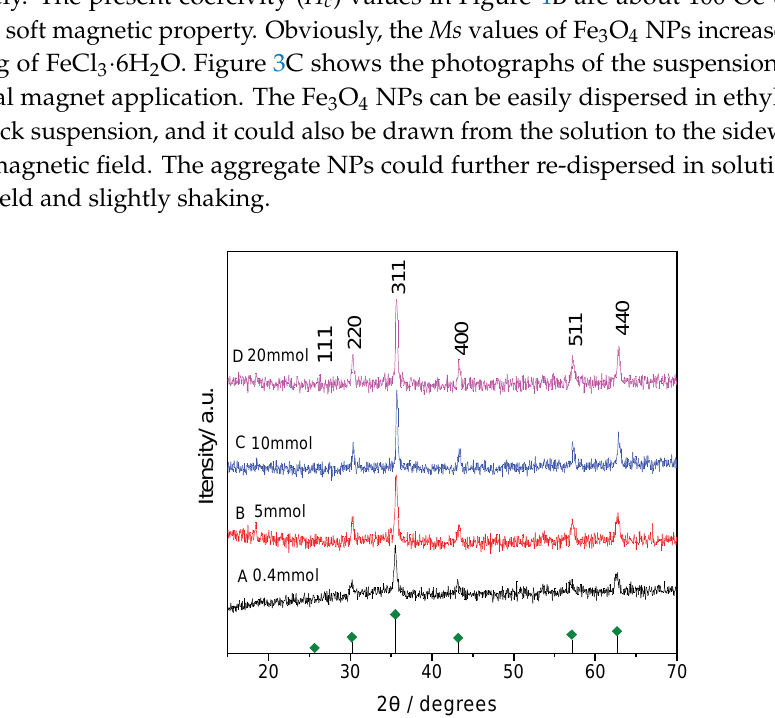
Figure 2. TEM images and size distribution patterns of Fe 3 O 4 with different molar ratio of FeCl 3 ·6H 2 O, ( A ) 0.4 mmol; ( B ) 5 mmol; ( C ) 10 mmol; ( D ) 20 mmol, the insets are the corresponding size distribution patterns. ( E – H ) is the corresponding magnification images.